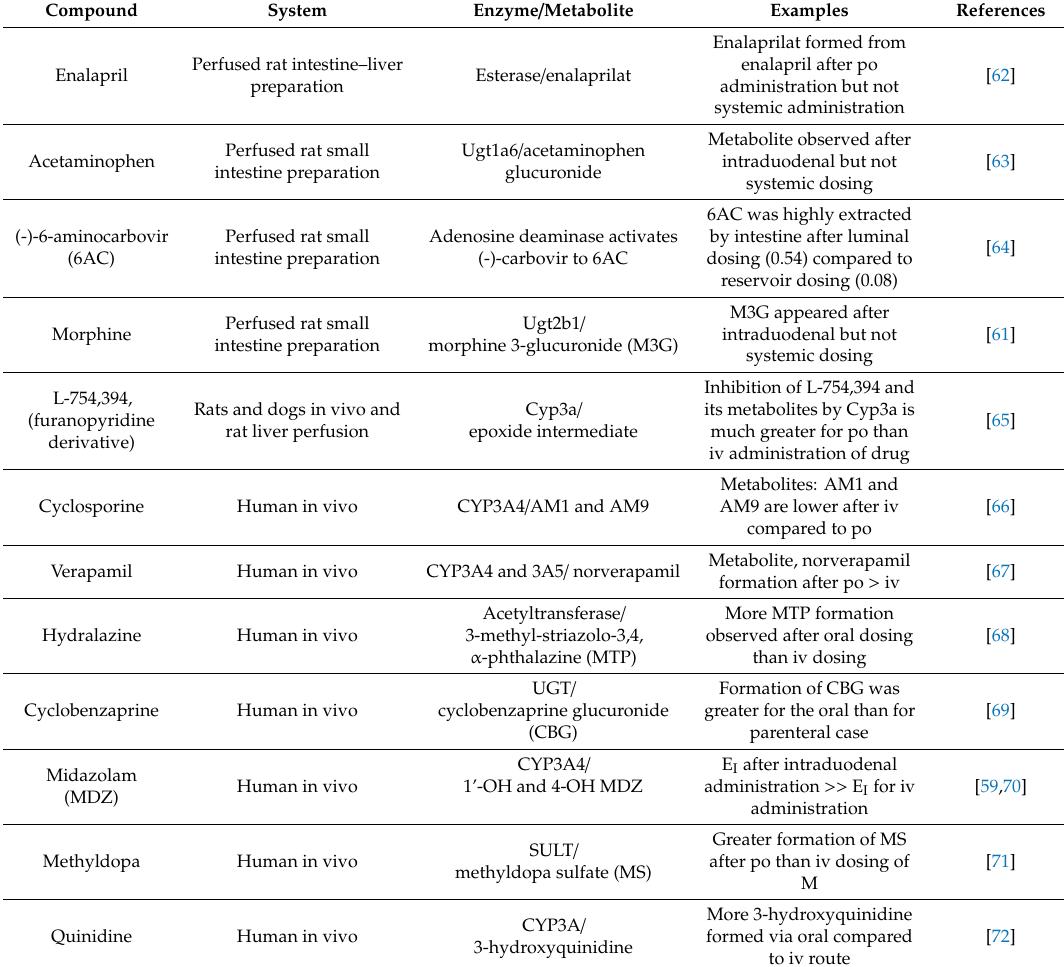
Table 1. Examples of route-dependent intestinal